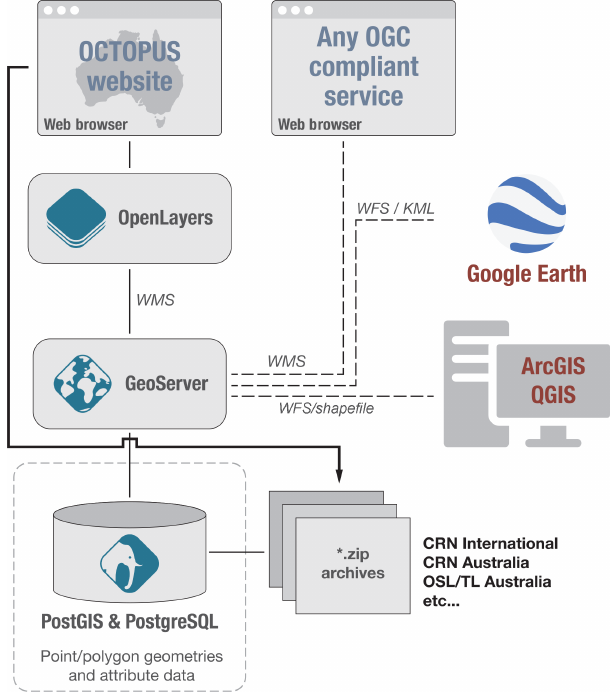
Figure 1. The setup of the OCTOPUS data-storage and -sharing platform. See text for more